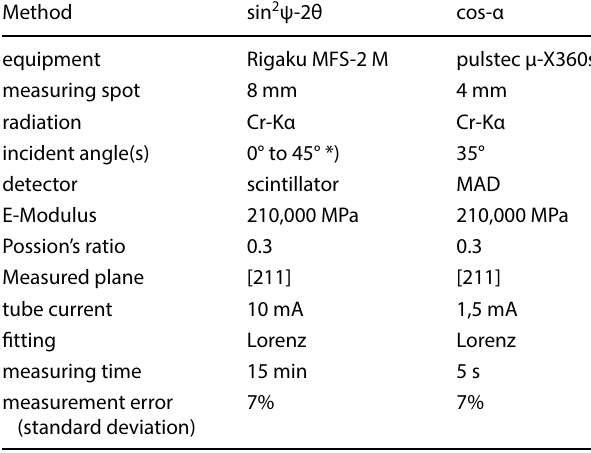
Table 2 Relevant measurement parameters